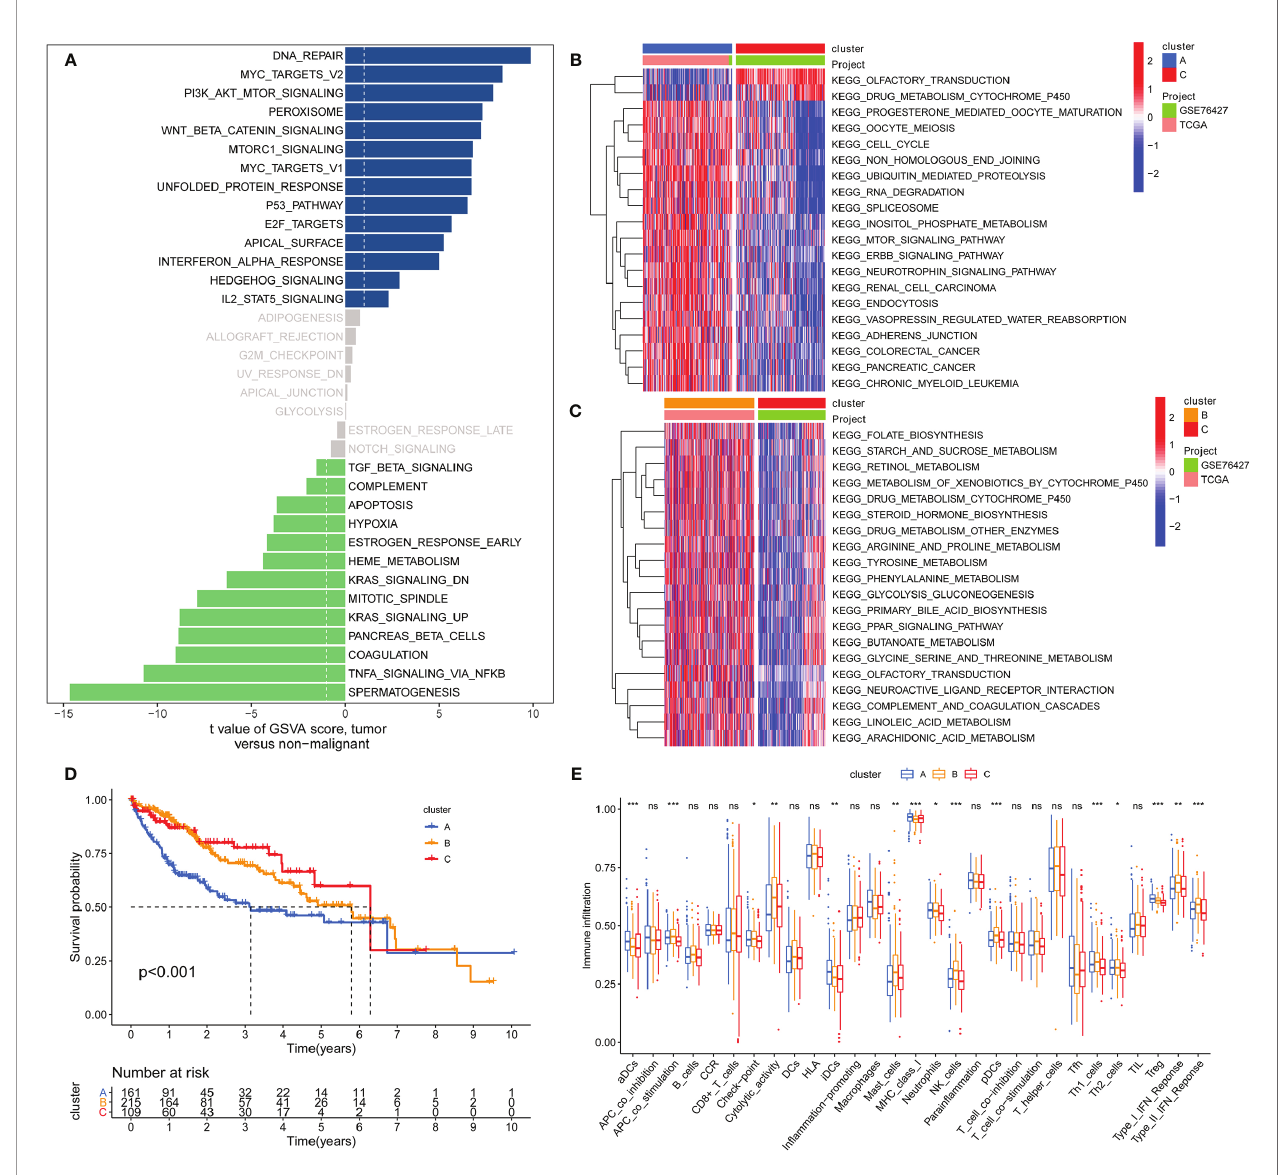
FIGURE 2 | GSVA analysis and unsupervised clustering analysis based on differential expression of genes to identify different epigenetic modi fi cation patterns and classify patients for further analysis. (A) Enrichment of epigenetic-related genes (ERGs) in signaling pathways as determined by GSVA analysis; (B) Cluster-A was mainly enriched in pathways related to cancers such as mTOR signaling, ERBB signaling, cell cycle and some tumors; (C) Cluster-B was prominently linked to metabolism pathways such as linoleic acid metabolism, arachidonic acid metabolism and ether butanoate metabolism; (D) Kaplan – Meier analysis revealed that cluster-A model correlated with poor survival (Group A vs. Group B, P =0.001; Group B vs. Group C, P =0.491; Group A vs. Group C, P =0.002); (E) Determination of differences of immune cells among the three clusters based on the ssGSEA algorithm (The enrichment score is calculated by using the empirical cumulative distribution function). * indicate P < 0.05; ** indicate P < 0.01; *** indicate P < 0.001; ns indicate no signi fi